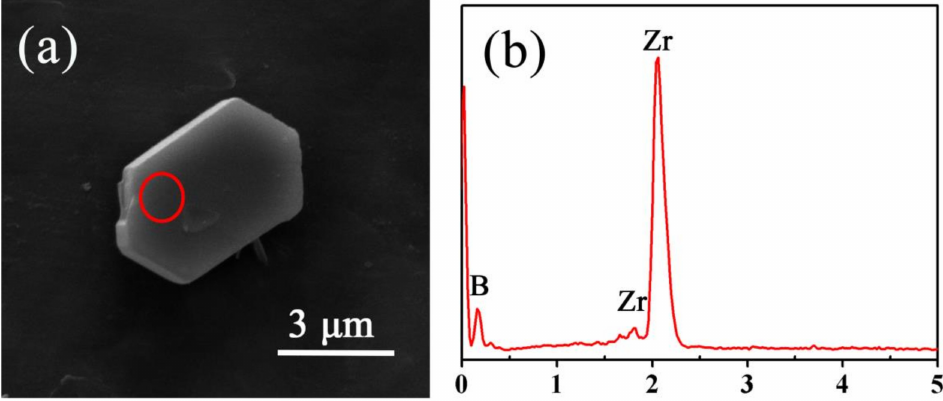
Figure 7. ( a ) SEM image with EDS with EDS ( b ) of as-prepared ZrB 2 -SiC powders fired at 1250 ◦ C for 20 min with 60 mol % excess B 4 C and a salt-medium/reactant weight ratio of